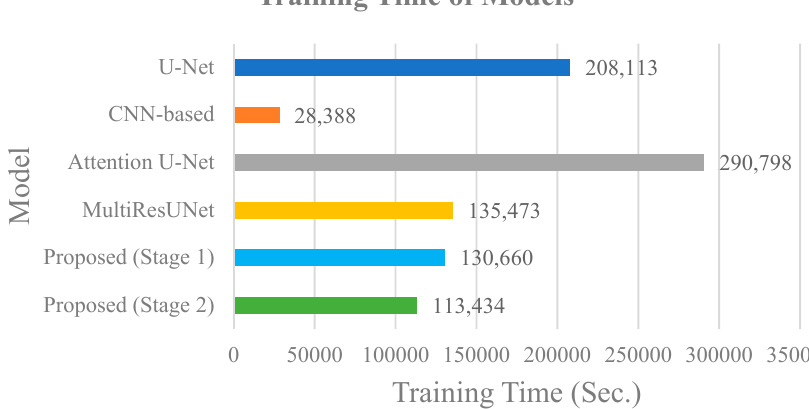
Figure 8. Comparison of training time costs of different models.